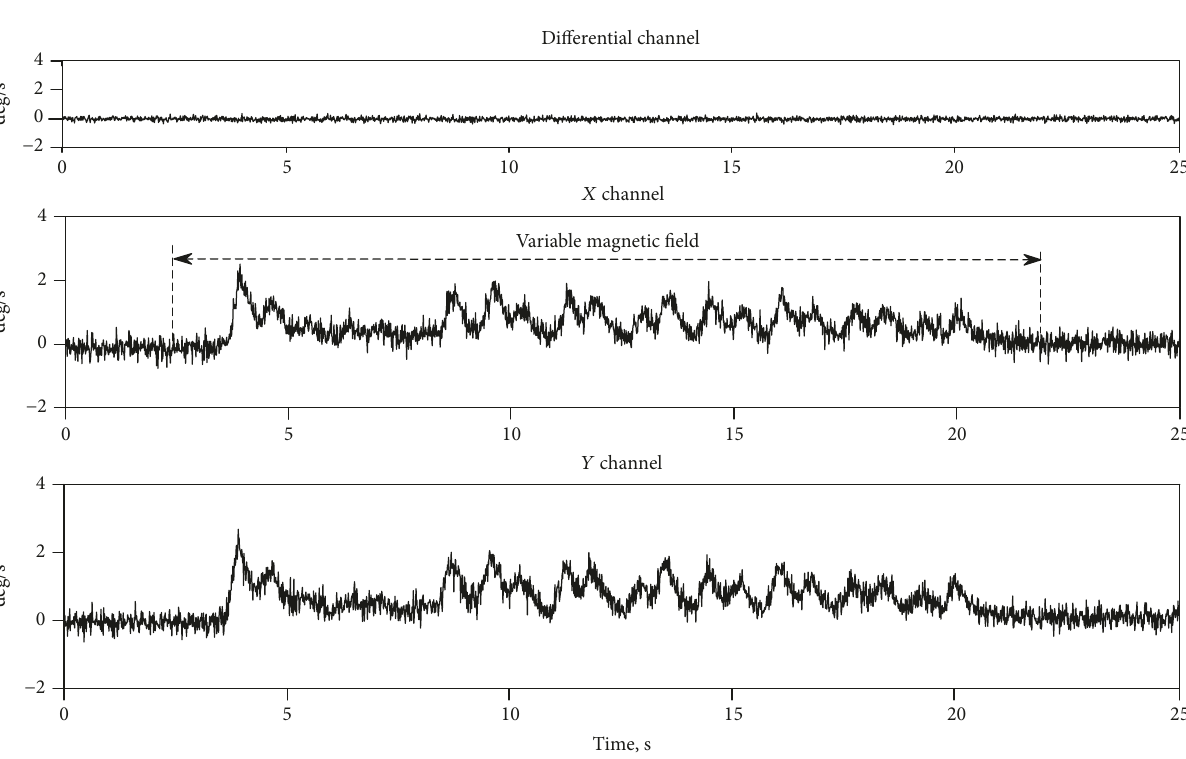
Figure 14: The X , Y , and di ff erential channel sensitivity to magnetic fi eld